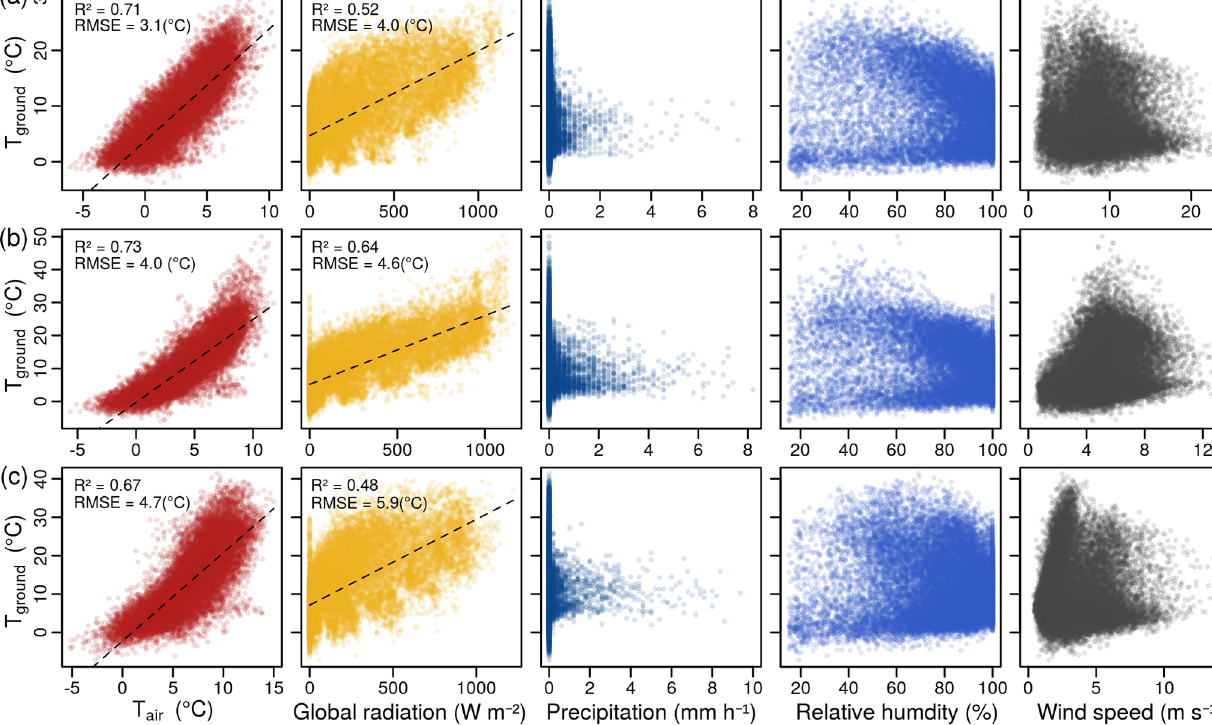
Figure E1. Correlation between hourly ground temperatures at 2cm depth and different meteorological variables at three different locations: (a) Tullu Dimtu (GT13 vs. BALE001), (b) EWCP Station (TM04 vs. BALE009), and (c) Tuluka (GT07 vs.